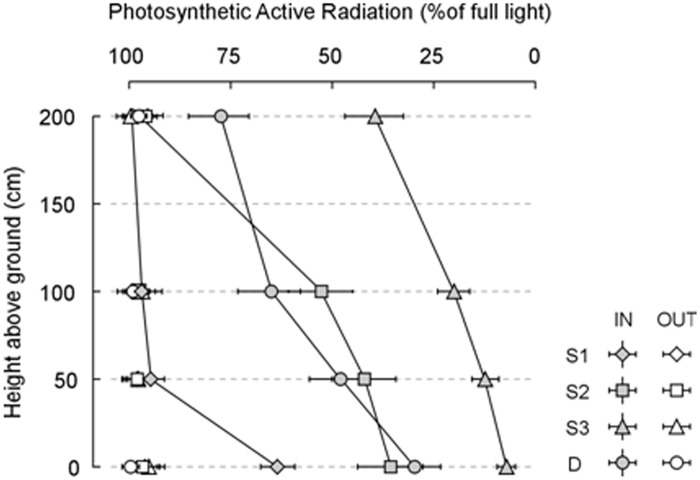
Effects of Genista aetnensis canopy on light regime.Photosynthetic active radiation (PAR) attenuation along the vertical profile under (IN) and outside (OUT) the canopy of Genista aetnensis individuals at different ontogenetic stage (S1, S2, S3, D) at the Vesuvius Grand Cone. Data refer to mean and s.e.m. of PAR, expressed as percentage of the maximum recorded value (full light, 1171 μmol m2 s-1). See S8 Table for statistical analysis.